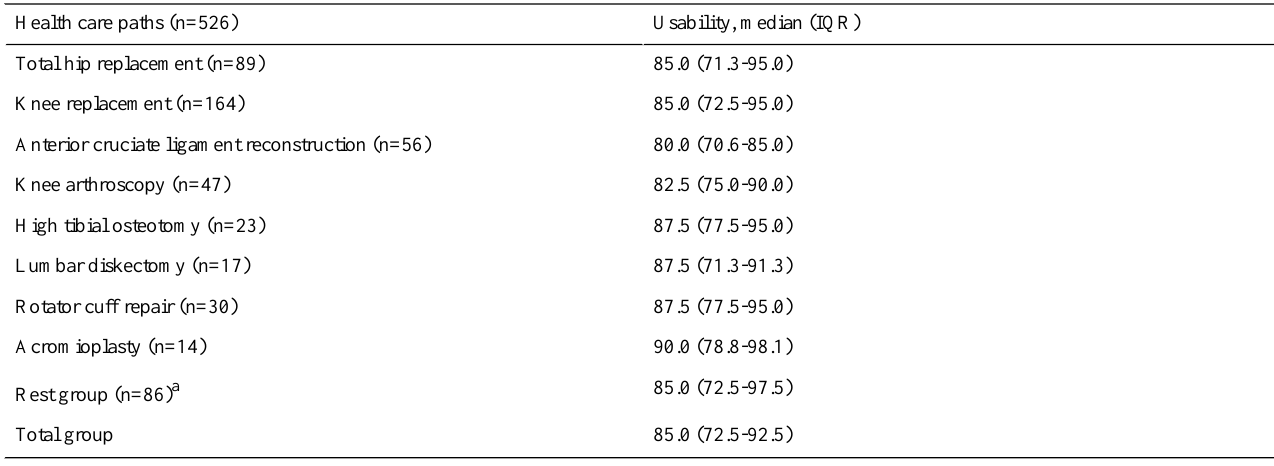
Table 2. System Usability Scale scores (0 to